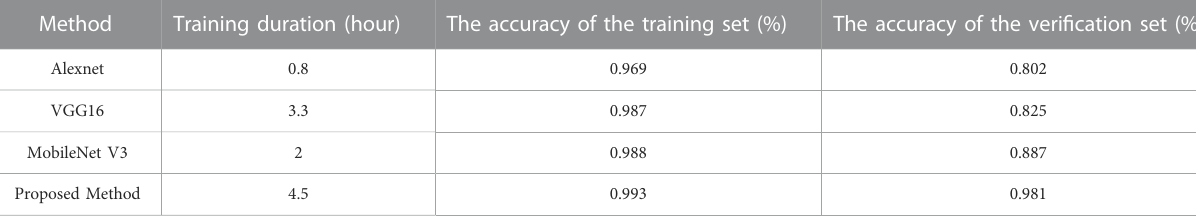
TABLE 3 Experimental results of different models.